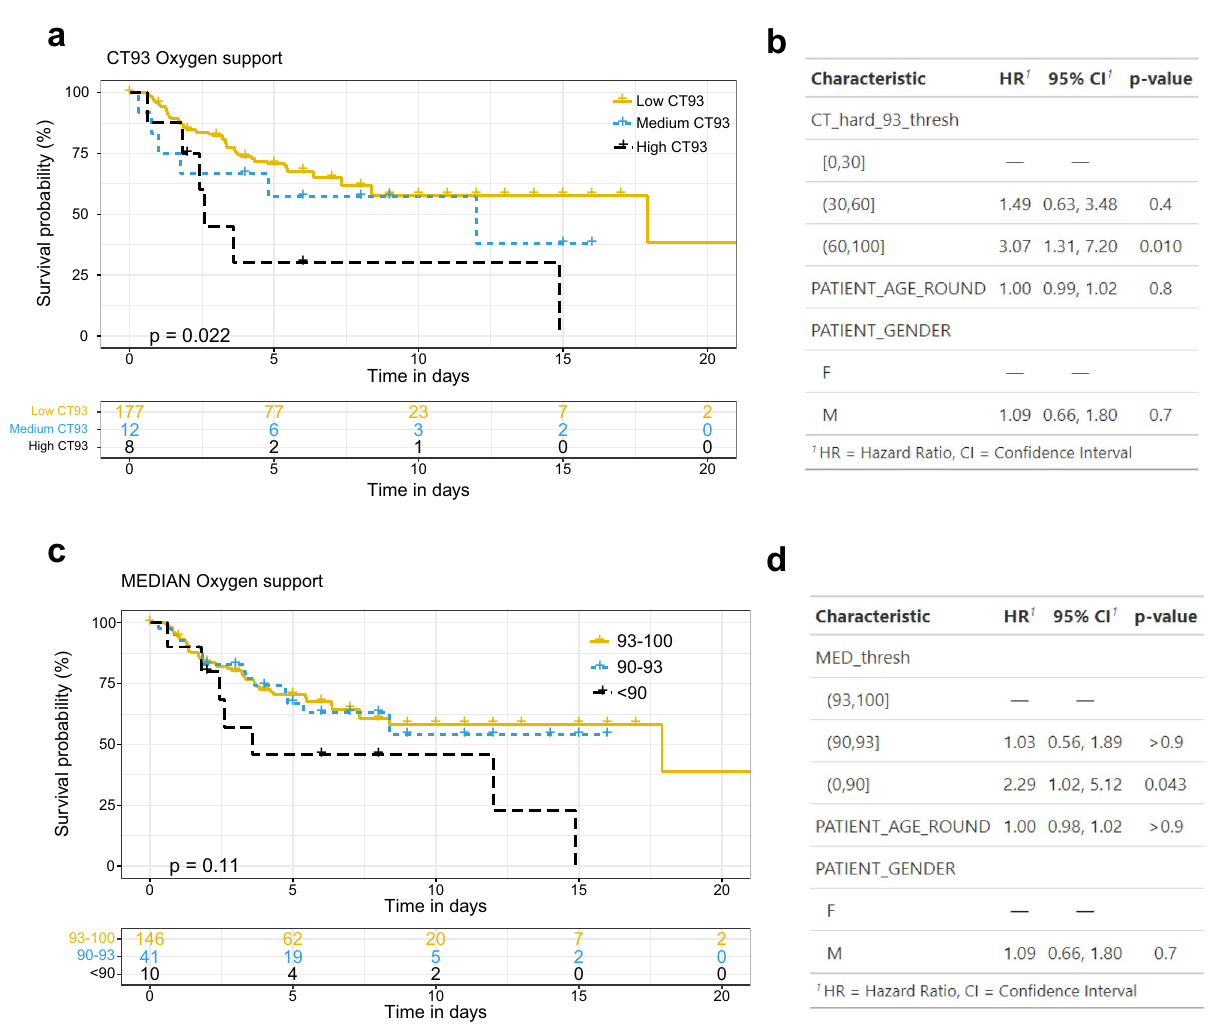
Figure 6. Time to event analysis of oxygen support using SpO2 CT93 and median measured during the first recorded hour. ( a ) Kaplan–Meier analysis of CT93 stratified as low (0 – 30), medium (30 – 60), and high (60 – 100) CT93. ( b ) Cox proportional hazards model summary, including stratified CT93, age, and sex. CT93 represents the fraction of time (in %) under the 93% SpO2 threshold. ( c ) Kaplan–Meier analysis of median stratified as bellow 90%, between 90 and 93% and above 93%. ( d ) Cox proportional hazards model summary, including stratified median, age, and